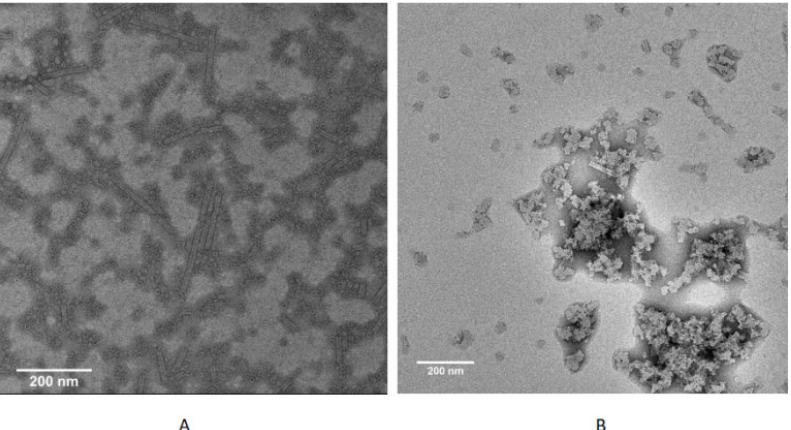
Figure 2. TMV rod assembly inhibition of compound 14b (200 nm scale bar): ( A ) 20S CP disk + RNA, ( B ) 20S CP disk + RNA + 10 µM 14b .